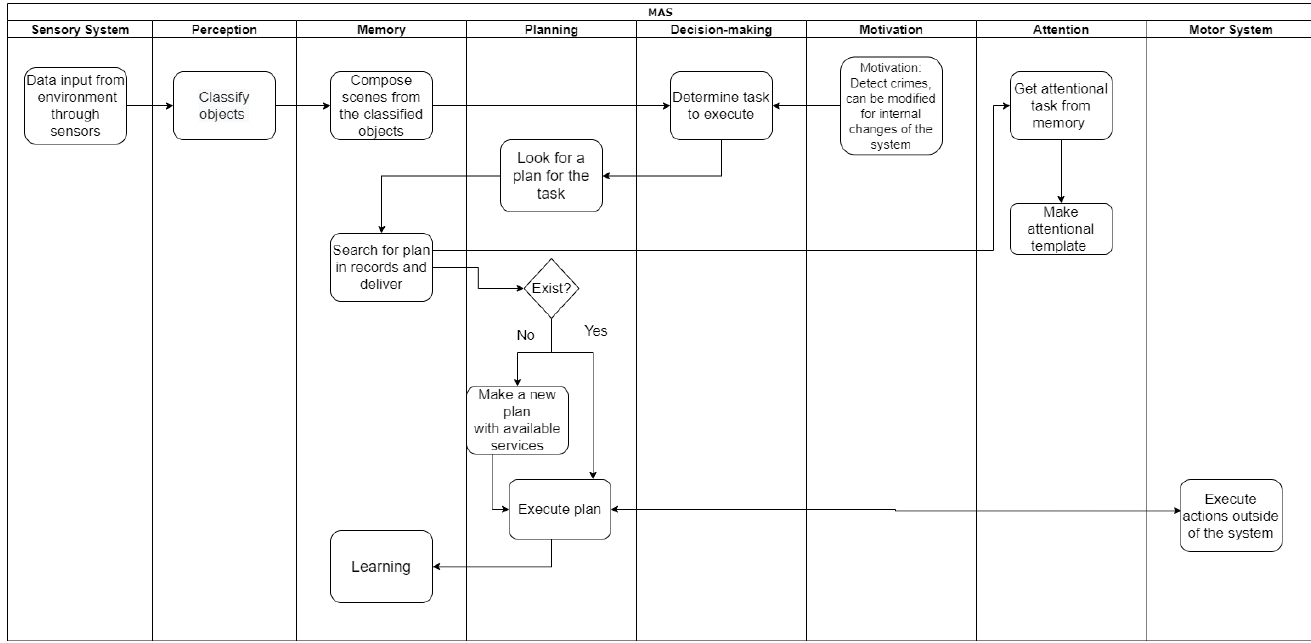
Figure 4. Diagram of flow between